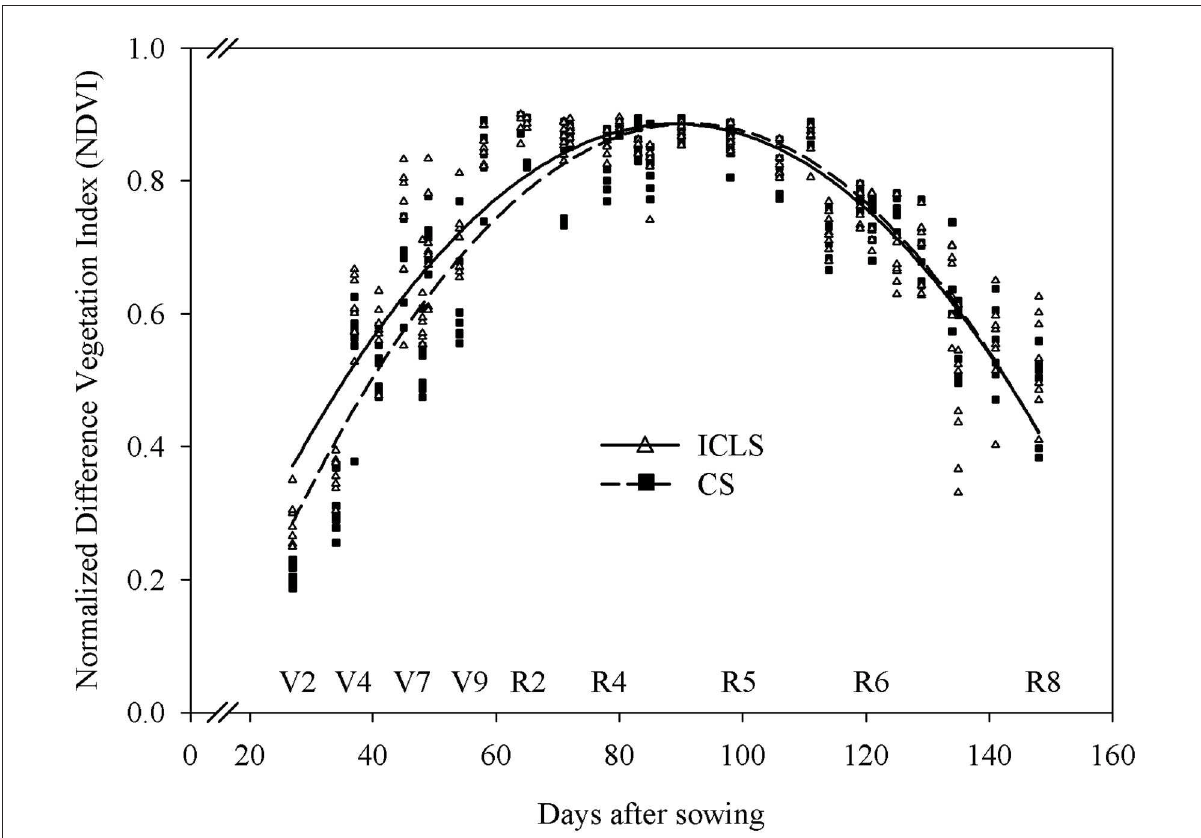
FIGURE3 The Normalized Difference Vegetation Index (NDVI) along soybean growth (days after sowing) under two production systems: ICLS, Integrated crop-livestock system; CS, Cropping